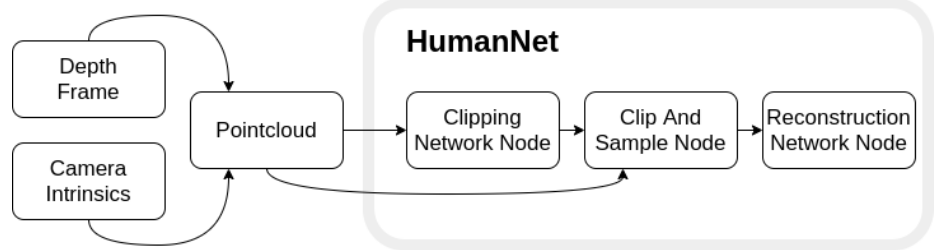
Figure 1. Proposed two-tiered network overview. Intrinsic camera matrix is applied to depth information in order to generate pointcloud. Pointcloud is then passed onto Clipping Network Node which finds predict the bounding box. The bounding box is then used along with initial point cloud to clip the Region of Interest and downsample. The result is then used to reconstruct the human